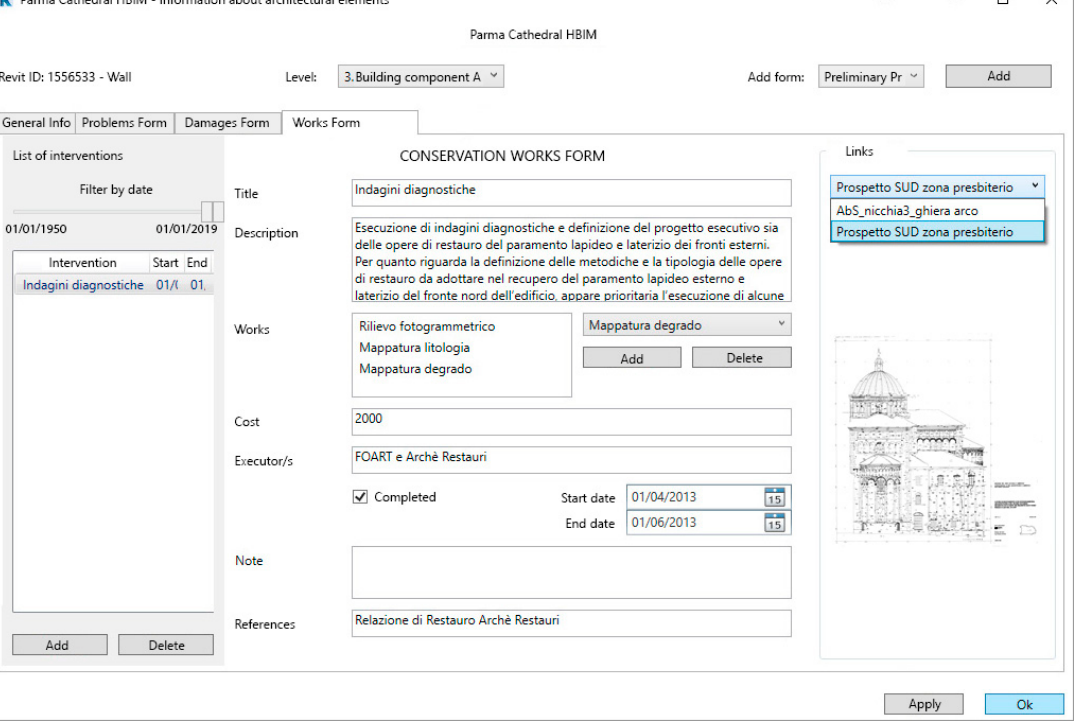
Figure 4. Example of Graphical User Interface. In this case, the form to enter conservation interventions is provided. On the left, the list of conservation intervention associated with the object is provided; the central part shows the details about the selected intervention; on the right, the links to external files can be visualized and